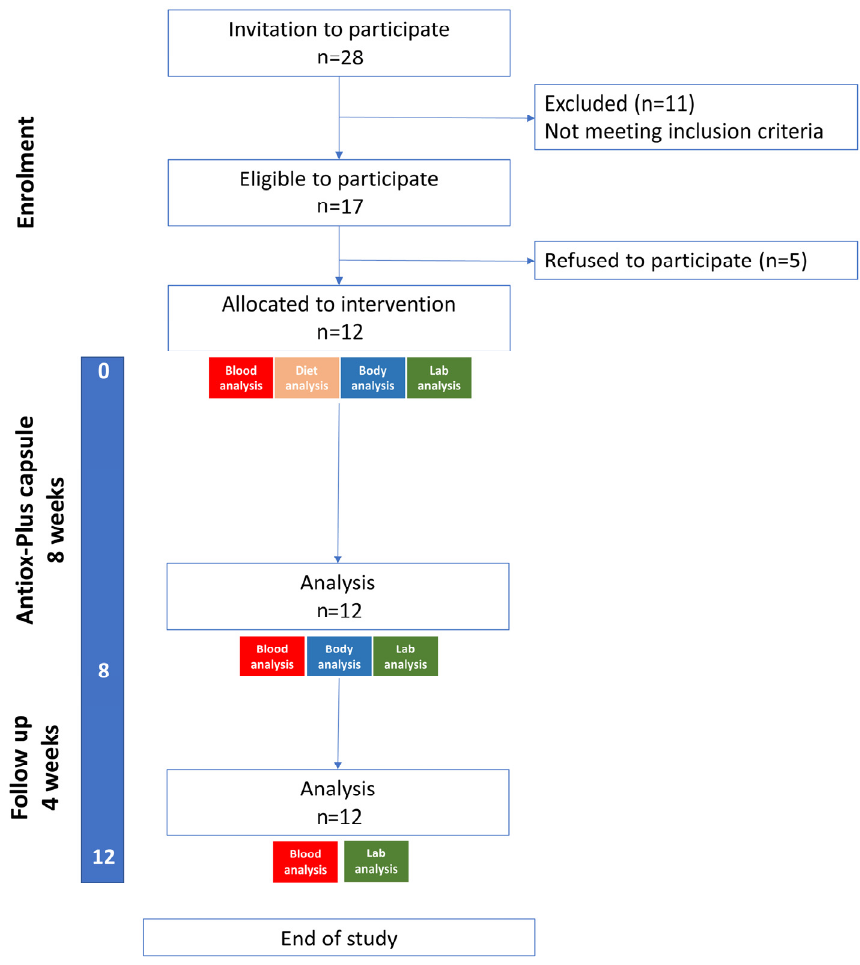
Figure 1. Study flow diagram. Table 1. Baseline characteristics of the